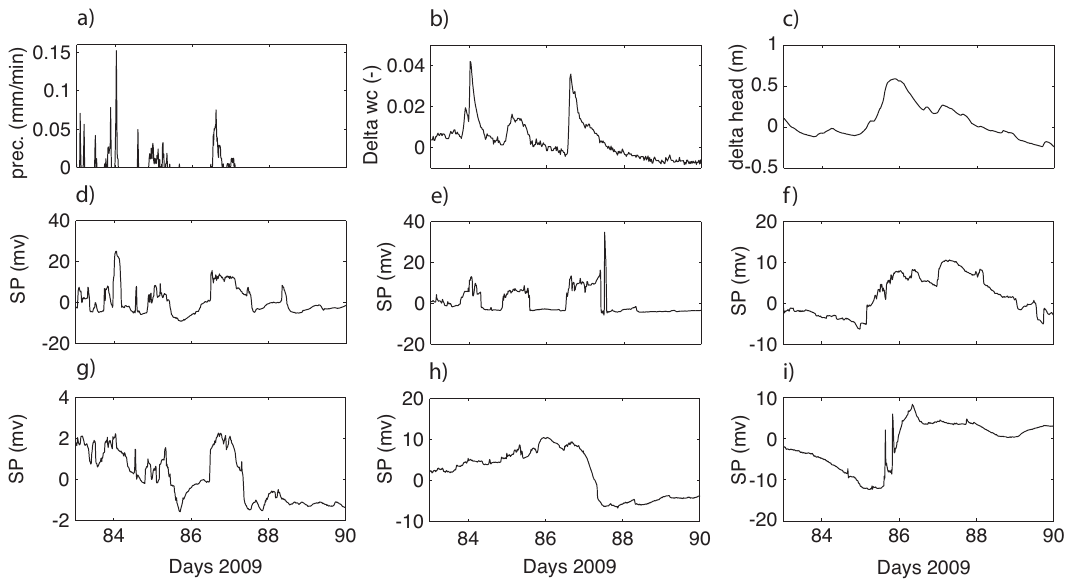
Fig. 6. Filtered time-series of (a) rainfall intensity, (b) water content at 10cm depth for station SB2M and (c) hydraulic head for piezometer R042 for time-scales less than two weeks during the major rainy period. Corresponding relative changes in the filtered SP signals are shown for (d) SP11, (e) SP3, (f) SP8, (g) SP6, (h) SP1, and (i) SP12.